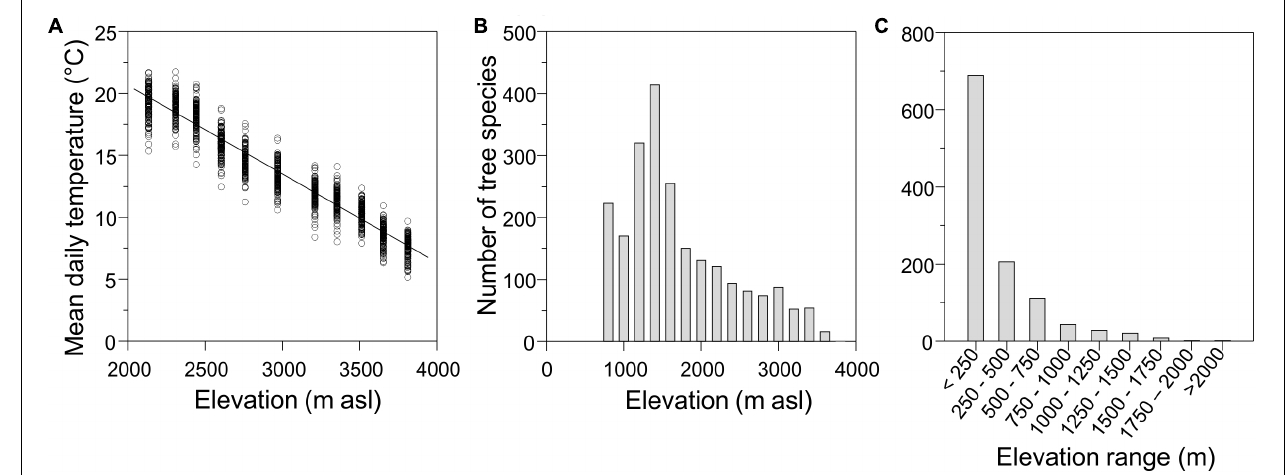
FIGURE 1 | (A) Mean daily temperature along an elevational gradient (2,135–3,812 m asl) in the southwestern region of the Peruvian Andes. Eleven temperature sensors (iButton DS1922L) were installed approximately every 150 m of elevation from 2,135 to 3,812 m asl. Each sensor was installed at a height of 1.5 m from the ground and remained in the field from February to July 2015, recording the temperature every 2:30 h. (B) Number of tree species in relation to elevation and (C) in relation to the extent of the distribution range. Panels (B,C) are based on data reported by Farfan-Rios et al. (2015) for tree plot censuses along along an elevation gradient from 800–3625 m asl in Manu National Park,